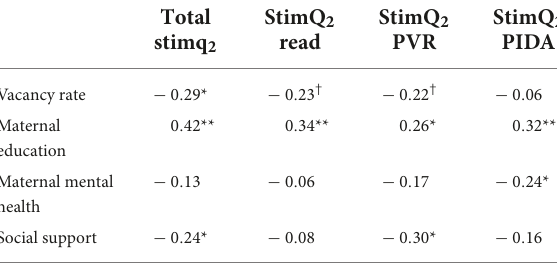
TABLE 3 Standardized regression coefficients for models predicting parent cognitively stimulating behaviors from neighborhood vacancy rates. StimQ 2 StimQ 2 Total read PVR stimq 2